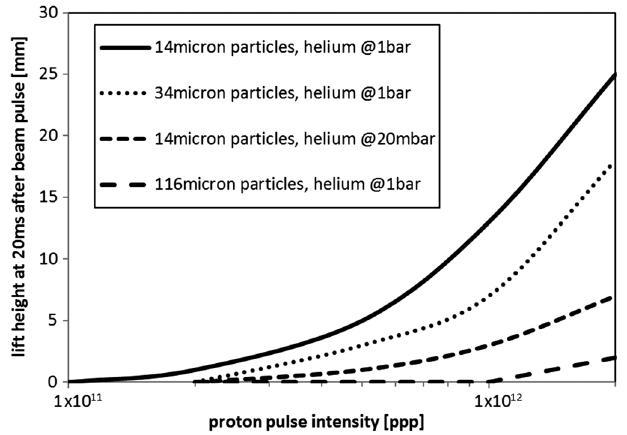
FIG. 6. Predicted particle lift due to pressure pulse and aerodynamic